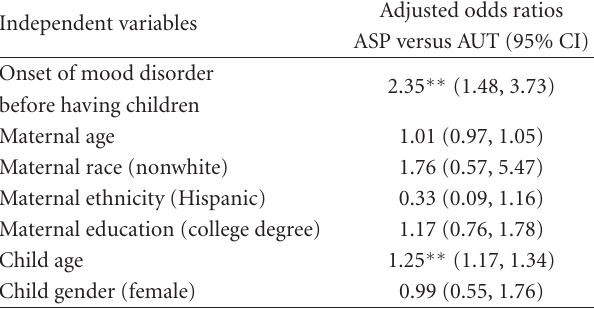
Table 4: Multivariate logistic regression analysis of Asperger syndrome (ASP) versus autistic disorder (AUT) phenotype among children with an ASD by timing of onset of maternal mood disorder among a ff ected mothers ( n =